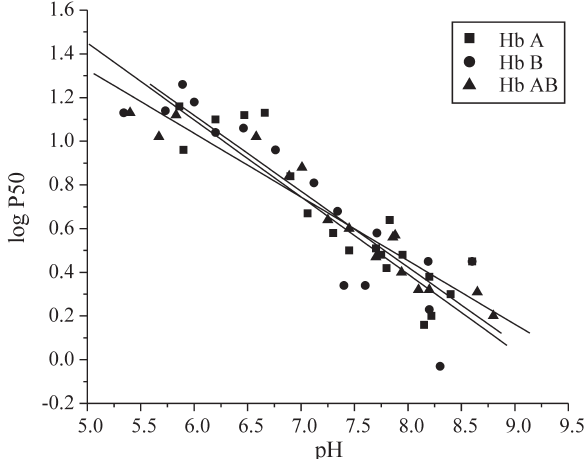
Figure 2 - pH dependence of P50 in stripped hemoglobin in presence of the chloride ion. Buffer Tris-HCl 0.05 M. Showing regresion lines in each